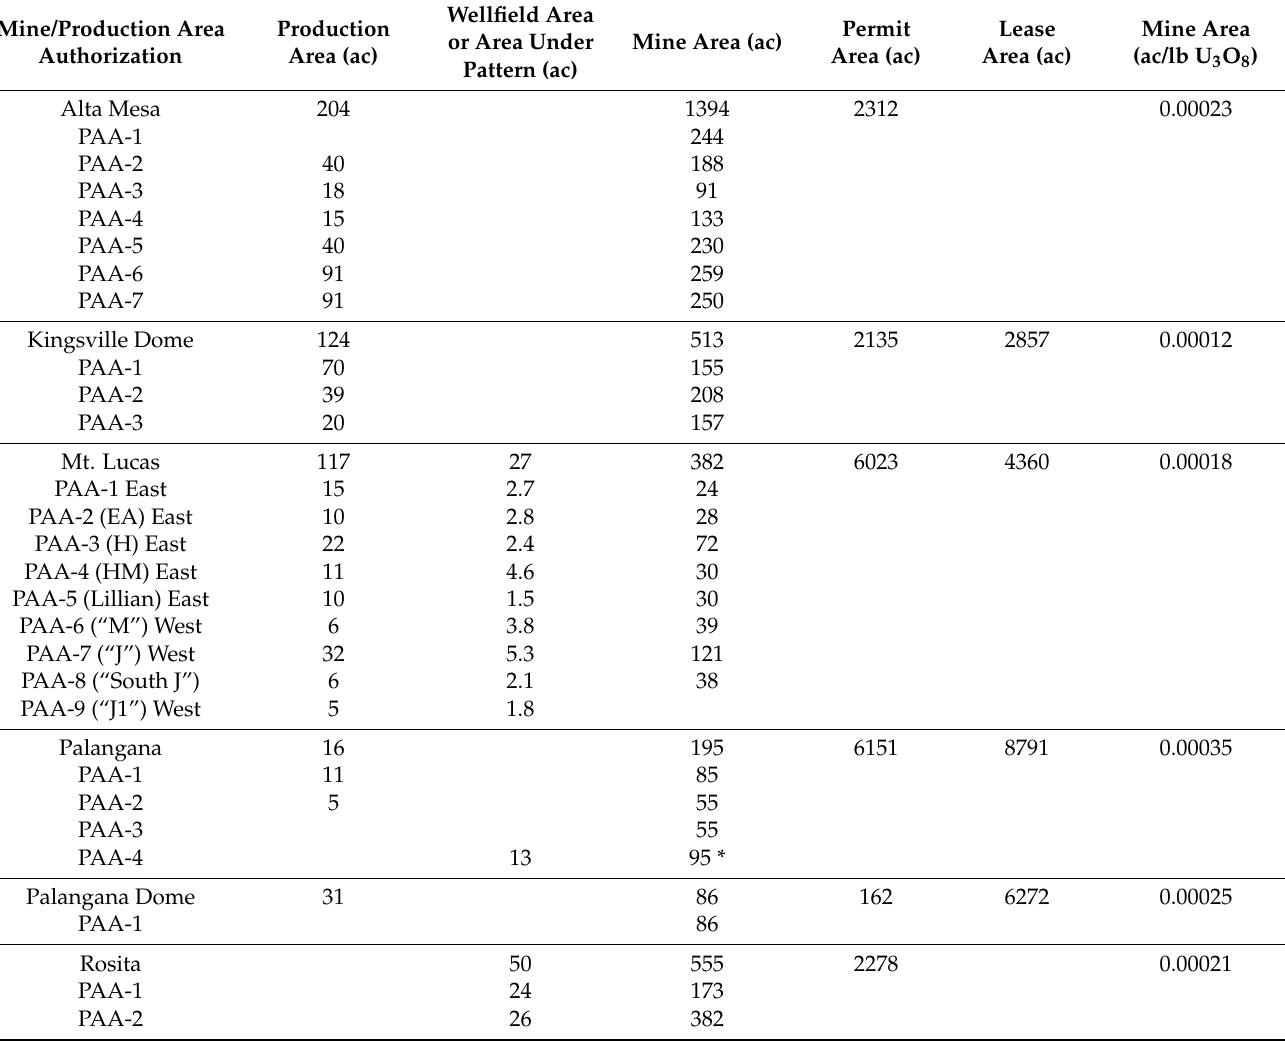
Table A2. Minimum areas associated with ISR